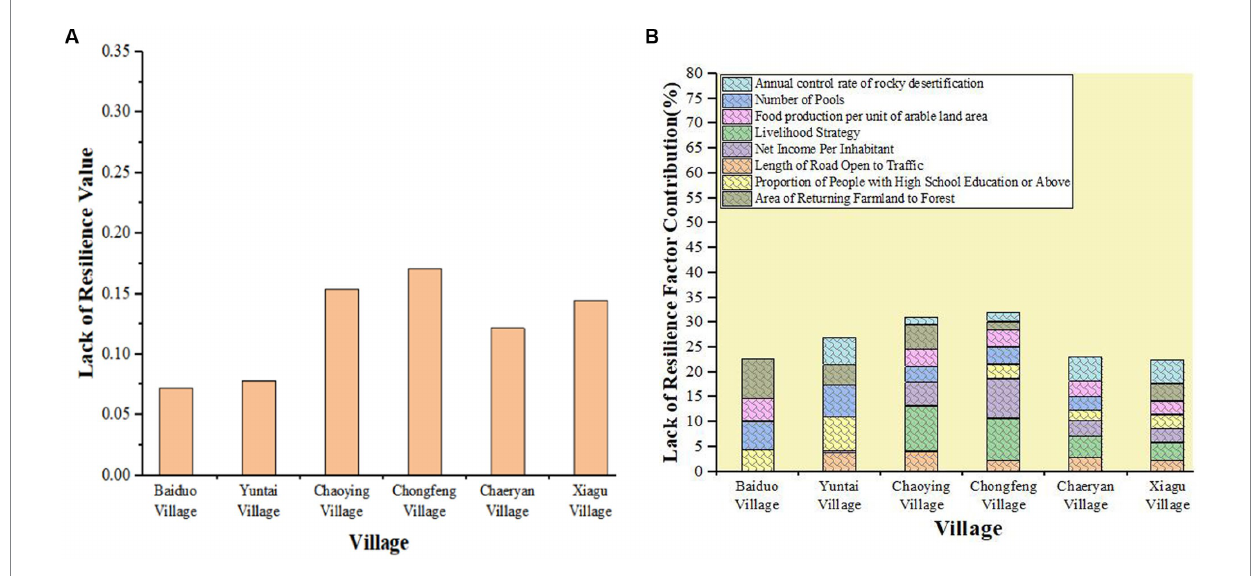
FIGURE 3 Lack of resilience analysis of villages ecosystem in the KDC. (A) Lack of resilience values. (B) Lack of resilience factors